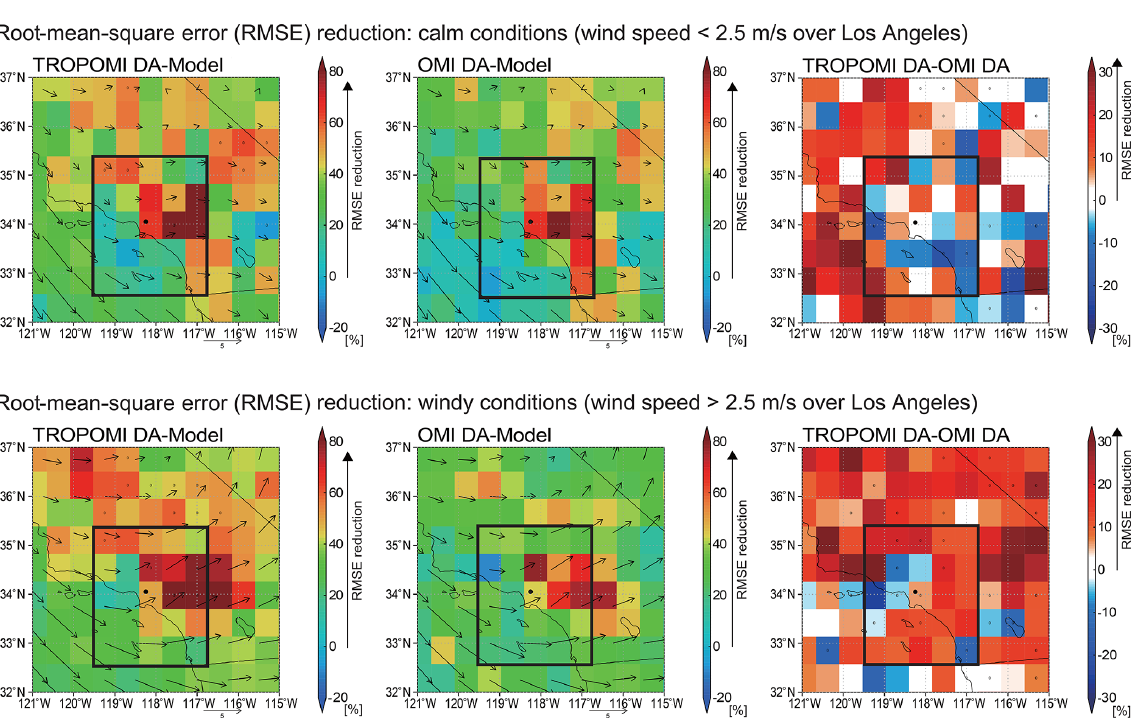
Figure 7. Root-mean-square error (RMSE) reduction for tropospheric NO 2 concentration fields against assimilated observations by data assimilation (DA) over Los Angeles under windy (wind speed > 2 . 5ms − 1 , top row) and calm (bottom row) conditions. The left, middle, and right columns show Tropospheric Monitoring Instrument (TROPOMI) DA, Ozone Monitoring Instrument (OMI) DA, and the differences between them, respectively. The unit is percentage (%). Arrows in the left and middle columns show surface winds derived from ERA-Interim reanalysis data. For the right column, grids with open circles indicate the differences in RMSE reductions between TROPOMI DA and OMI DA that are statistically significant at the 95% confidence level using the Mann–Whitney U test. The black circle indicates the location of Los Angles city